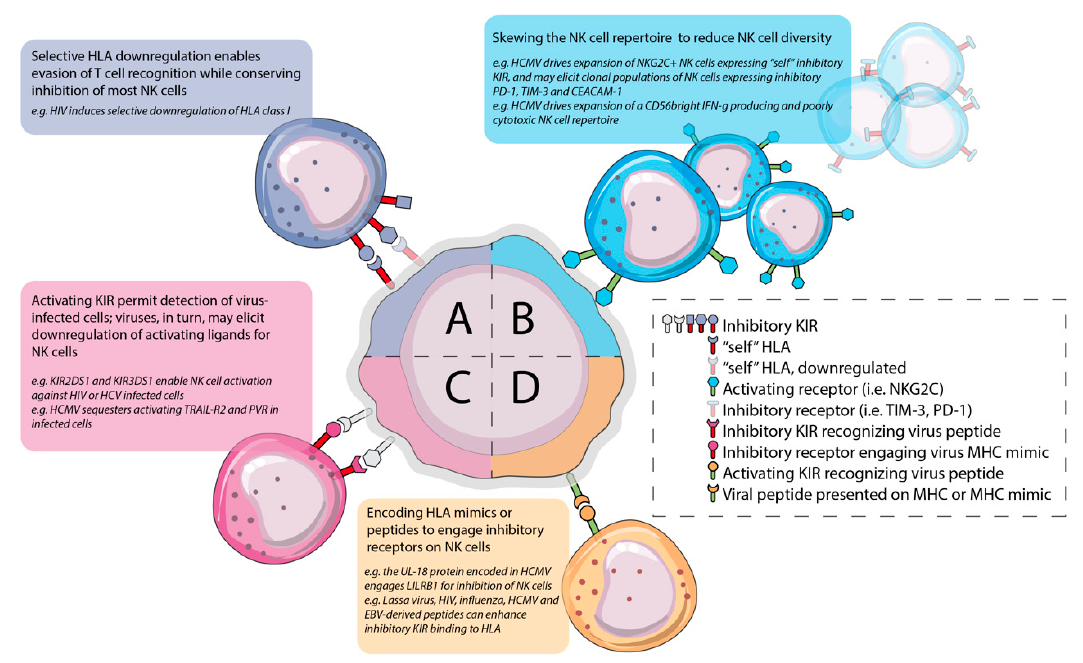
Figure 2. Interplay between virus infection and NK cells. Viruses and NK cells have co-evolved to enable virus persistence, host defense and symbiosis. Four examples are shown in this figure where the center cell represents an infected cell. A. Some viruses can selectively downregulate HLA molecules to avoid recognition by T cells. While this may create a target for the educated subset of NK cells, uneducated NK cells will not productively detect downregulation of HLA. Hence, the virus is taking a calculated risk that any given host may not be able to detect the loss of HLA that it induces. B. Viruses can skew the NK cell repertoire, reducing its diversity. In some instances, viruses (i.e., HCV) drive expansion of a CD56-negative exhausted NK cell population; others (i.e., HCMV) induce